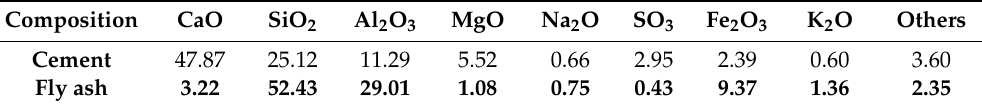
Table 1. Chemical composition of cementitious materials (weight /